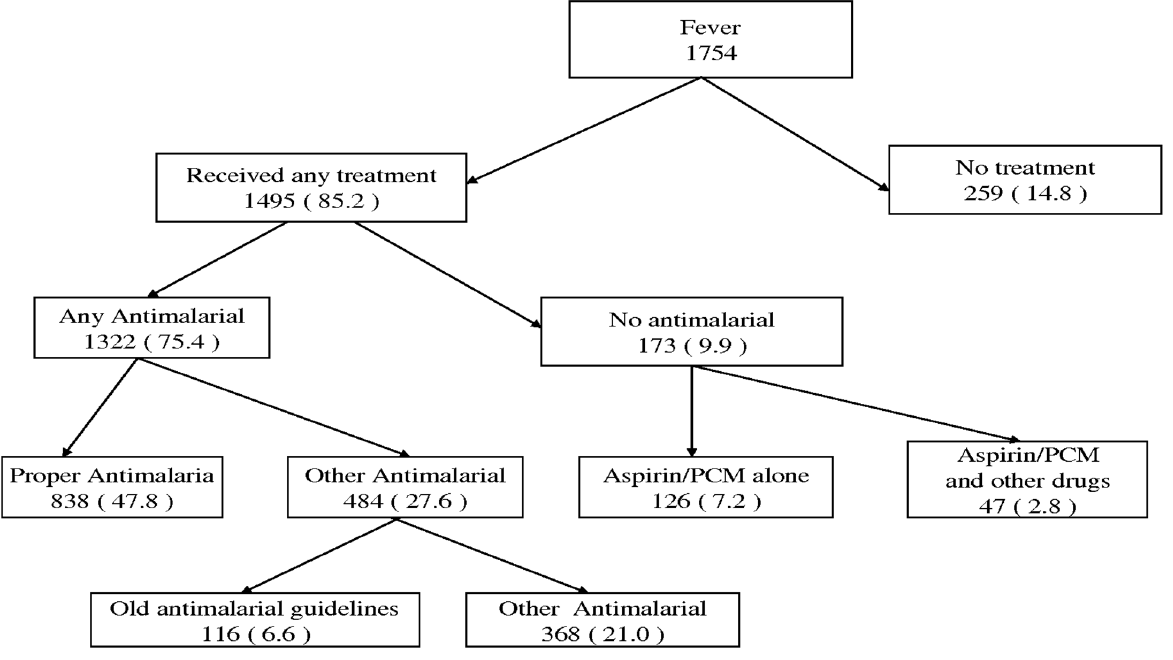
N N N PCM=Paracetamol. All proportions given above (in Old antimalarial guidelines refer to drugs that are no longer recommended